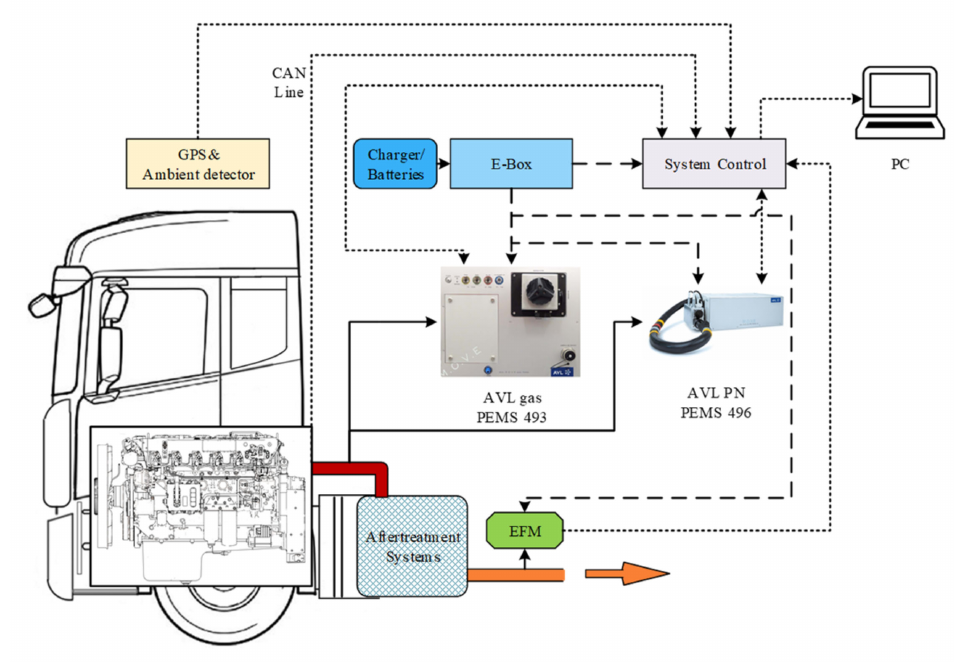
Figure 4. The schematic diagram of PEMS. Table 5. Data acquisition methods in the